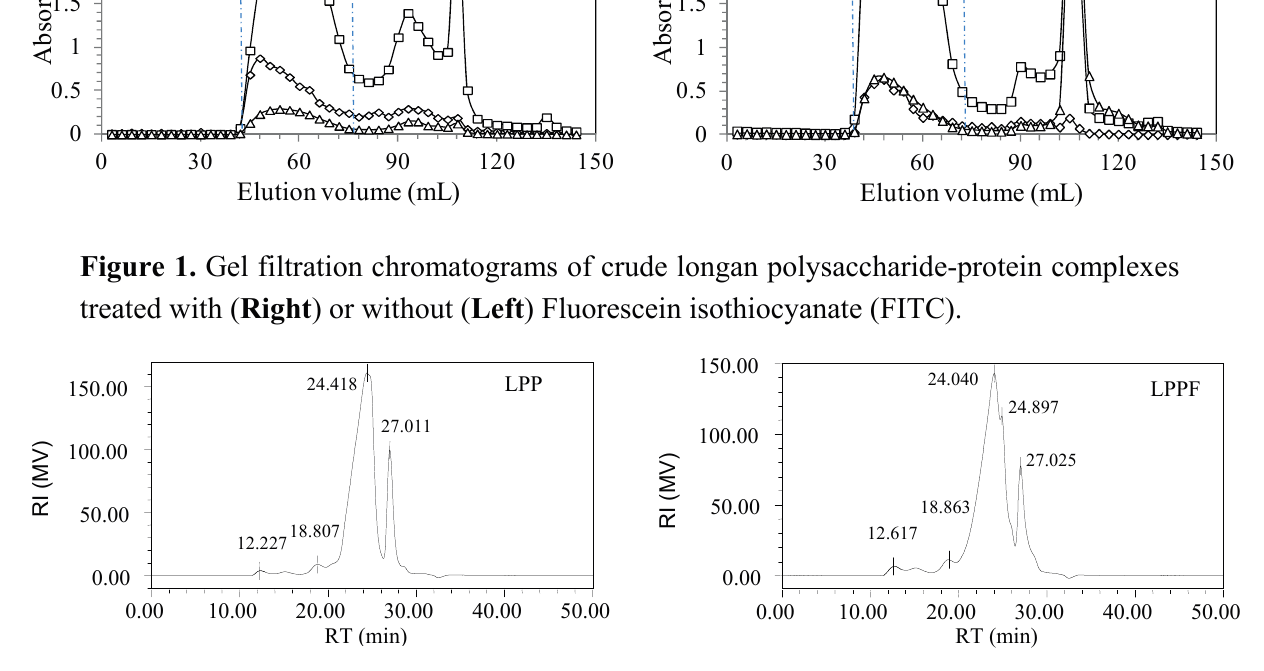
Figure 2. High performance size exclusion chromatograms of longan polysaccharide-protein complexes (LPP) ( Left ) and Fluorescein isothiocyanate-labeled LPP (LPPF) ( Right ) obtained by refractive index